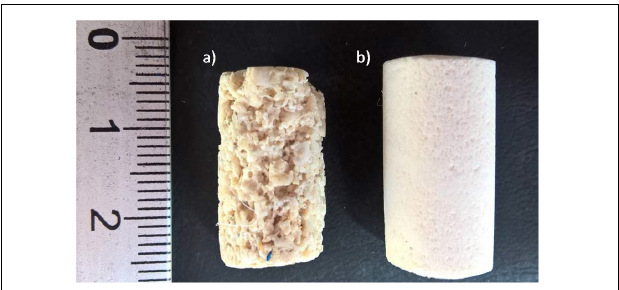
FIGURE 1 | Studied samples are made of carbonate grainstones. (a) Favignana grainstones (b) Orfento Grainstones, characterized by different texture and permeability ( Table 1 ). Samples have a diameter of about 10 mm with a height of about 20 mm.